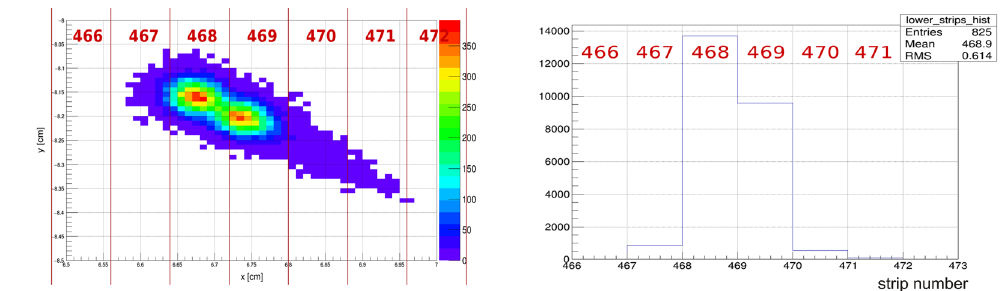
Figure 6. (Left) Cluster on the readout plane; (right) strip cluster signal.